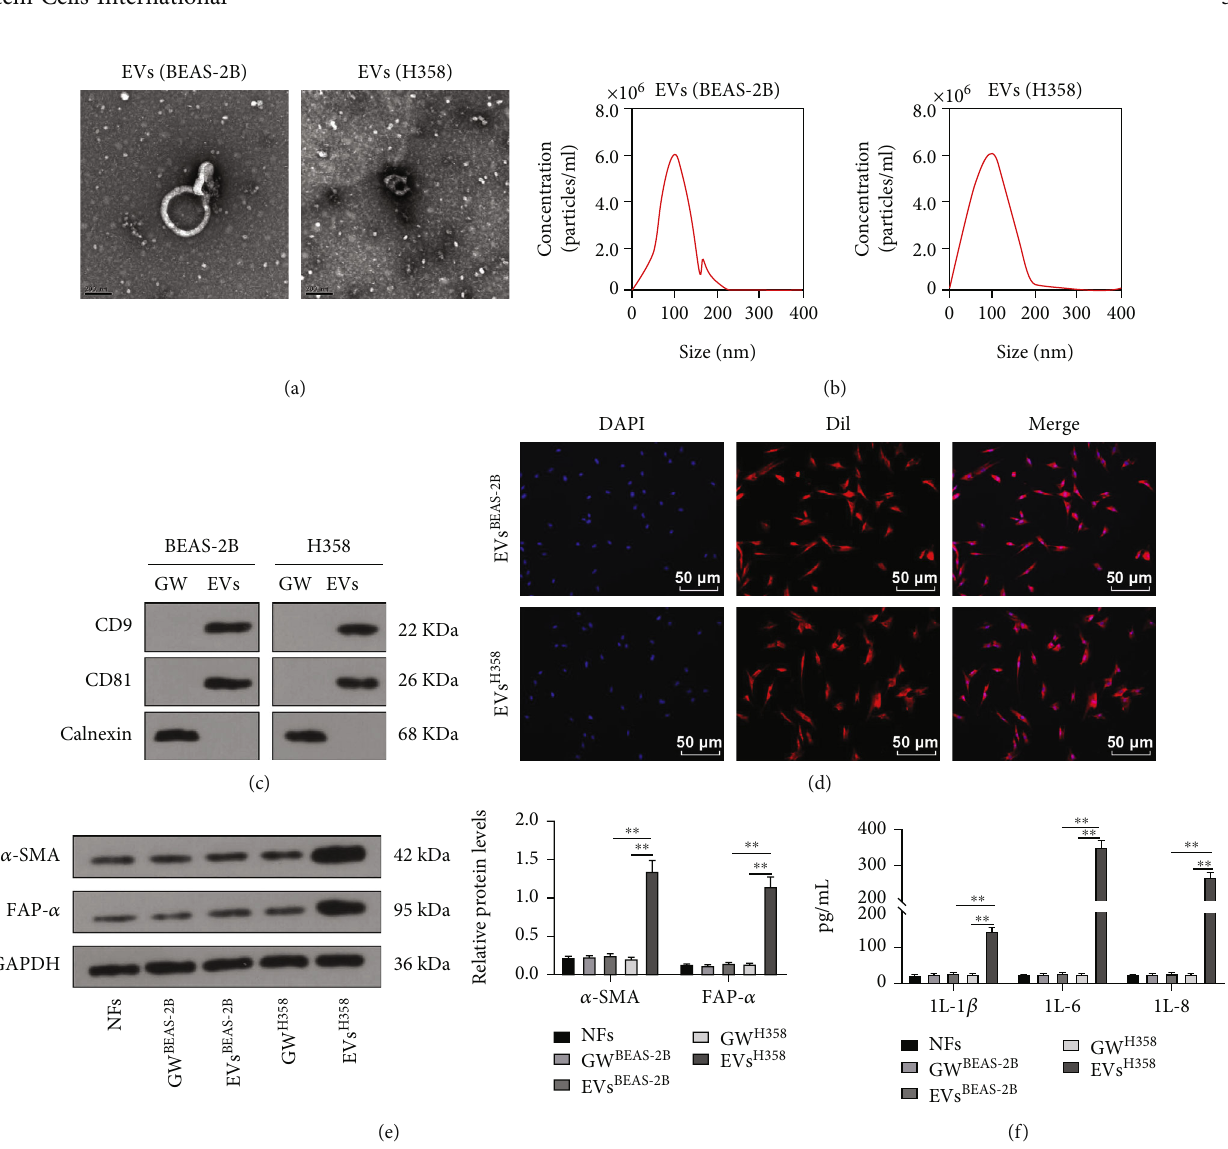
Figure 1: T-EVs promoted CAFs activation. EVs were isolated from LC cell H358 and normal lung epithelial cell line BEAS-2B. (a) The morphology of EVs was observed by TEM; (b) NTA analysis of particle size distribution; (c) the expression of positive markers CD9 and CD81 and negative marker Calnexin on EV surface were detected by WB. EVs were labeled with red fl uorescent dye Dil and cocultured with NFs; (d) the internalization of EVs by NFs was detected by immuno fl uorescence; (e) the protein levels of α -SMA and FAP- α on the surface of CAFs were detected by WB; and (f) the levels of cytokines IL-1 β , IL-6, and IL-8 were detected by ELISA. Cell experiment was repeated three times. One-way ANOVA was used for data comparison among multiple groups in Figures (e) and (f), and Tukey ’ s test was used for the post hoc test. ∗∗ P < 0 : 01